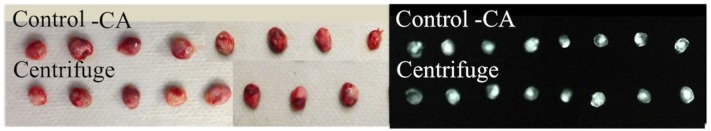
Macroscopic (left panel) and radiographic (right panel) aspects of ectopic bones between two groups (Control-CA: Control group of constant acceleration groups, Centrifuge: Centrifuge group).